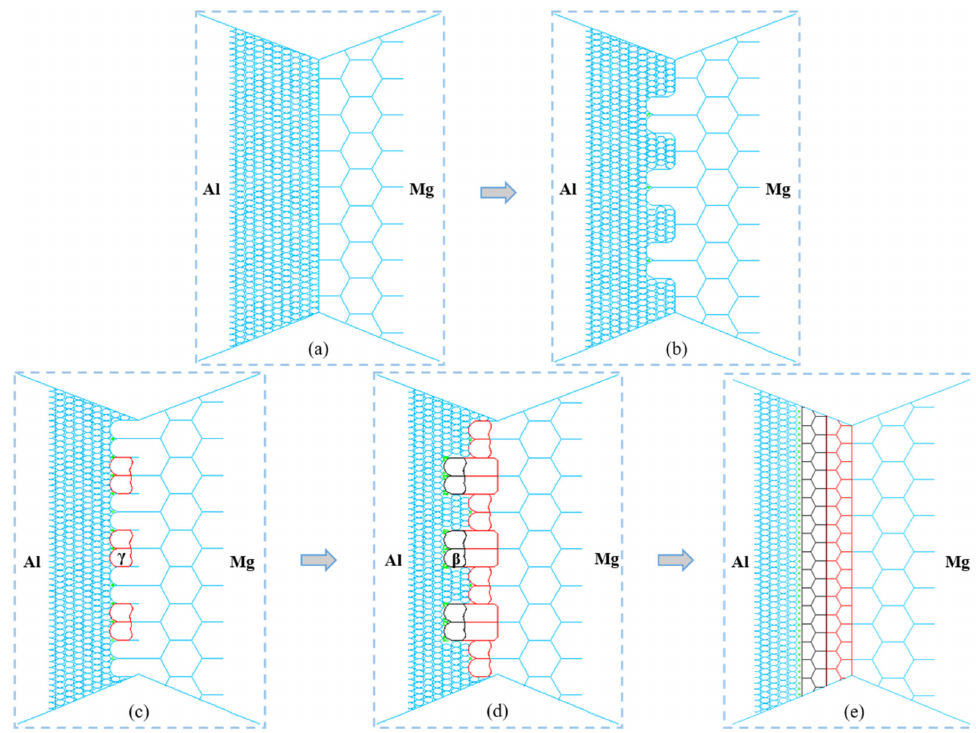
Figure 8. Schematic of IMCs formation at the bonding interface of AA2024/AZ31B FSW weld: ( a ) before welding, ( b ) first stage of welding;( b ) second stage of welding, ( c ) third stage of welding, ( d ) fourth stage of welding, and ( e ) completion of